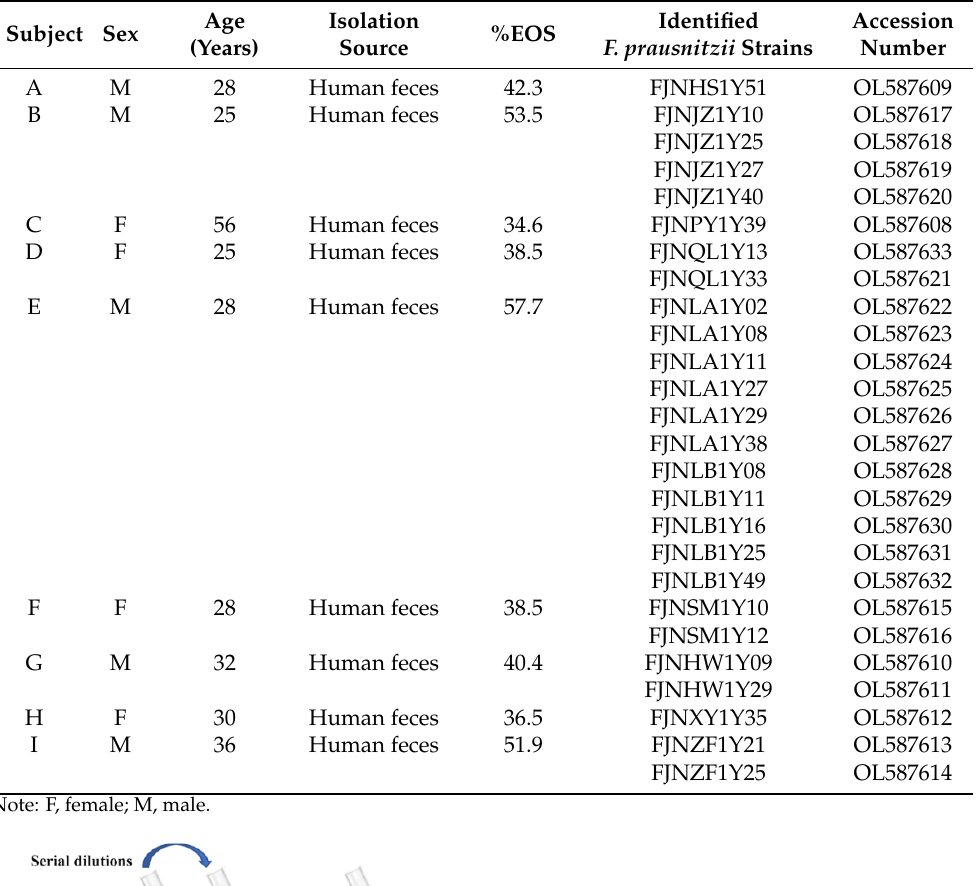
Table 1. Information about fecal samples and newly identified F. prausnitzii strains.